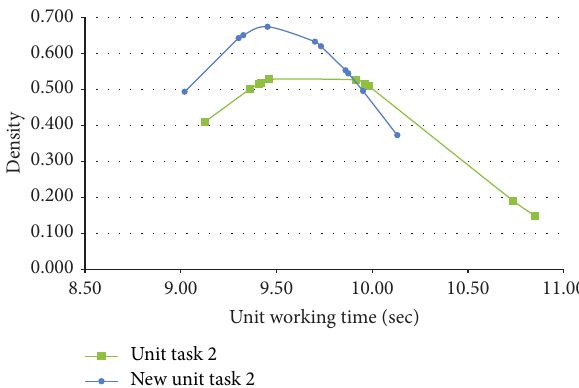
Figure 14: Working time distribution curve for unit task 2 of the assembly